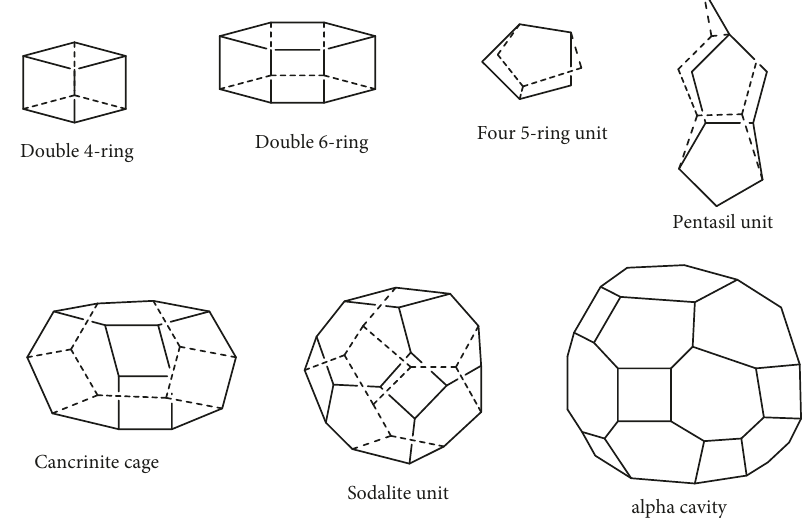
Figure 4: Cavities and subunits common among framework types adapted from